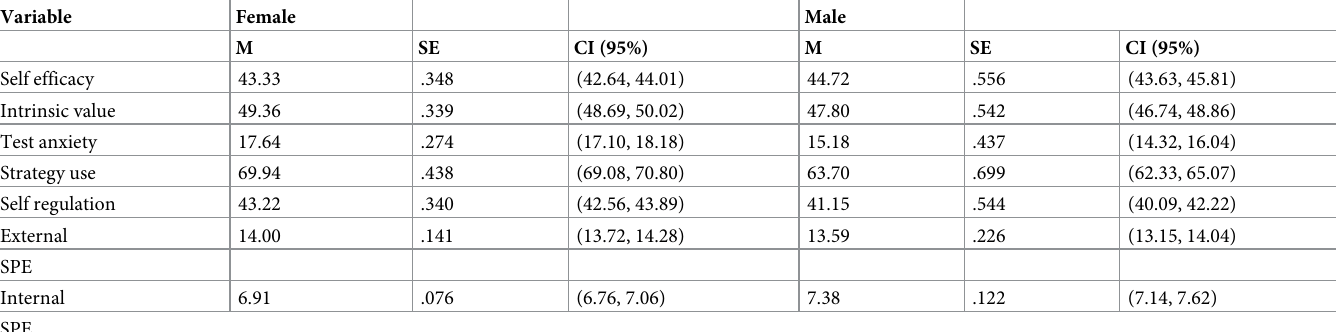
Table 3. Descriptive statistics and 95%Confidence Intervals (CI) for Mean values (M) of tested variables in women and men. Variable